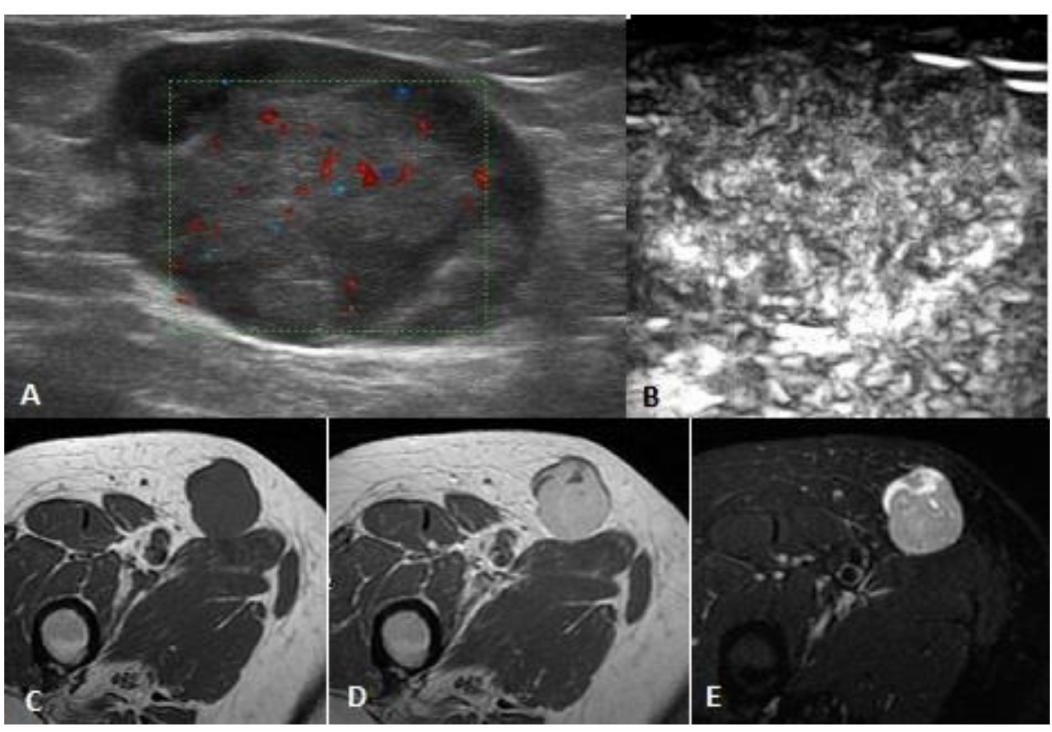
Figure 2. Female, 69 years old, right thigh low-grade leiomyosarcoma: US shows a round, inhomogeneous, hypoechoic, subcutaneous lesion with regular and with only few vessels at power Doppler ( A ). CEUS ( B ) demonstrates homogeneous and di ff use vascularization. MRI shows a subcutaneous mass with regular edges, homogeneous hypo-intense in T1-weighted images ( C ) and hyper-intense in STIR images ( E ) with inhomogeneous enhancement after contrast medium ( D